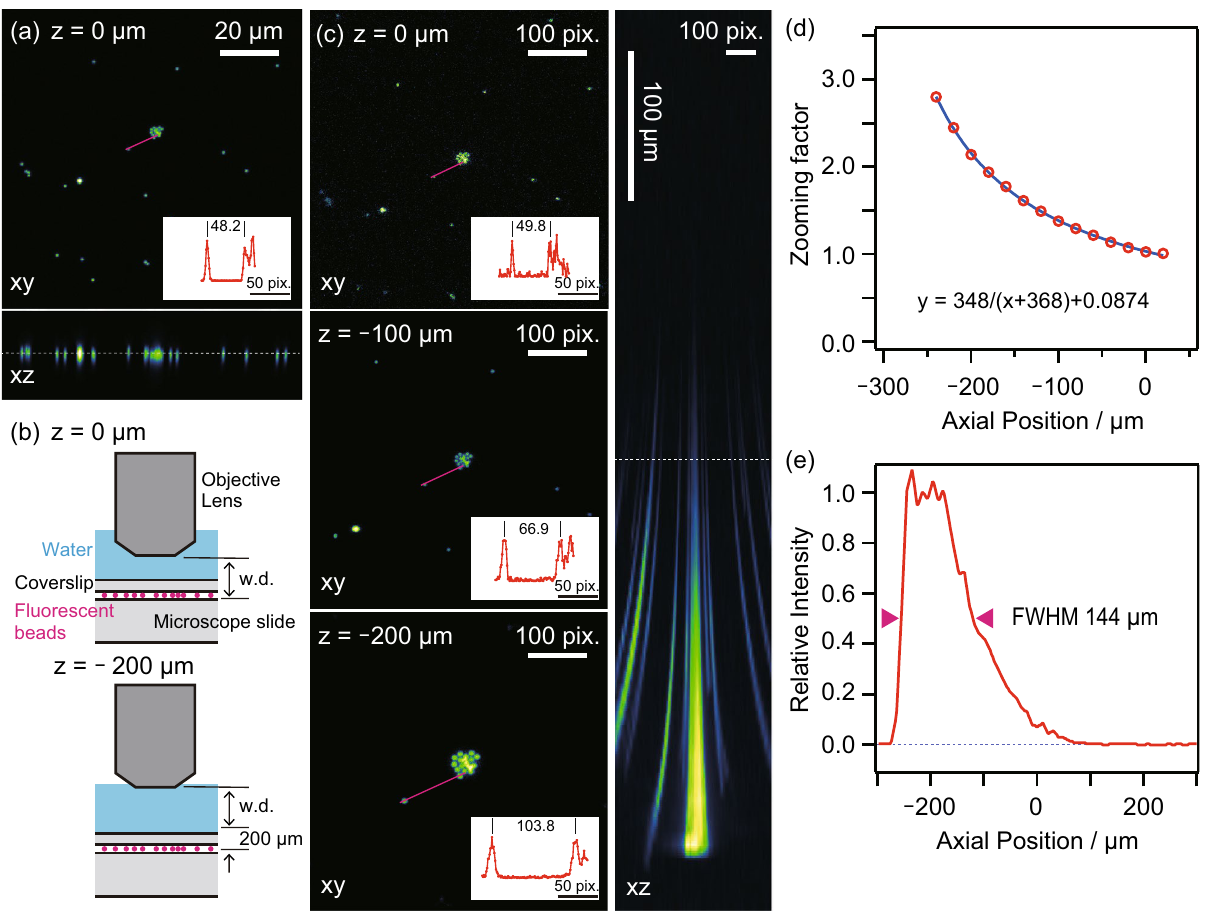
Figure 2. TPLSM images of fluorescently labelled beads on a coverslip. ( a ) Xy image at the focus ( z = 0 µm) and reconstructed xz image from z- stacks (30 µm thick) measured by the Gaussian beam. ( b ) Relative configurations of the objective lens and the specimen. ( c ) Xy image at the focus, 100 and 200 µm position apart from the focus and reconstructed xz image from z- stacks (600-µm thick) measured by the Bessel beam created by the light- needle creating device. The inset panels indicate the fluorescence intensity profiles along the red lines in the xy images. The scale bars along xy images were shown as their pixels. ( d ) Zooming effect of the Bessel beam scanned images depending on the position from the focus. ( e ) The axial fluorescence intensity profile of TPLSM image measured by the Bessel